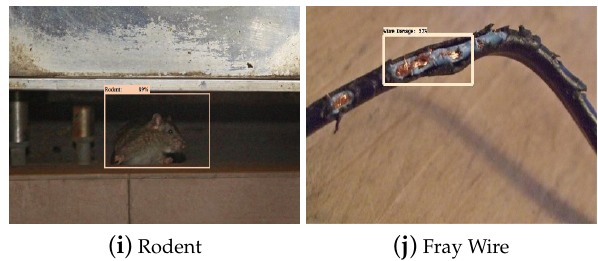
Figure 7. Structural Defects ( a – d ), degradation in HVAC system ( e – g ), infestation ( h , i ), electrical damage ( j ) during Offline